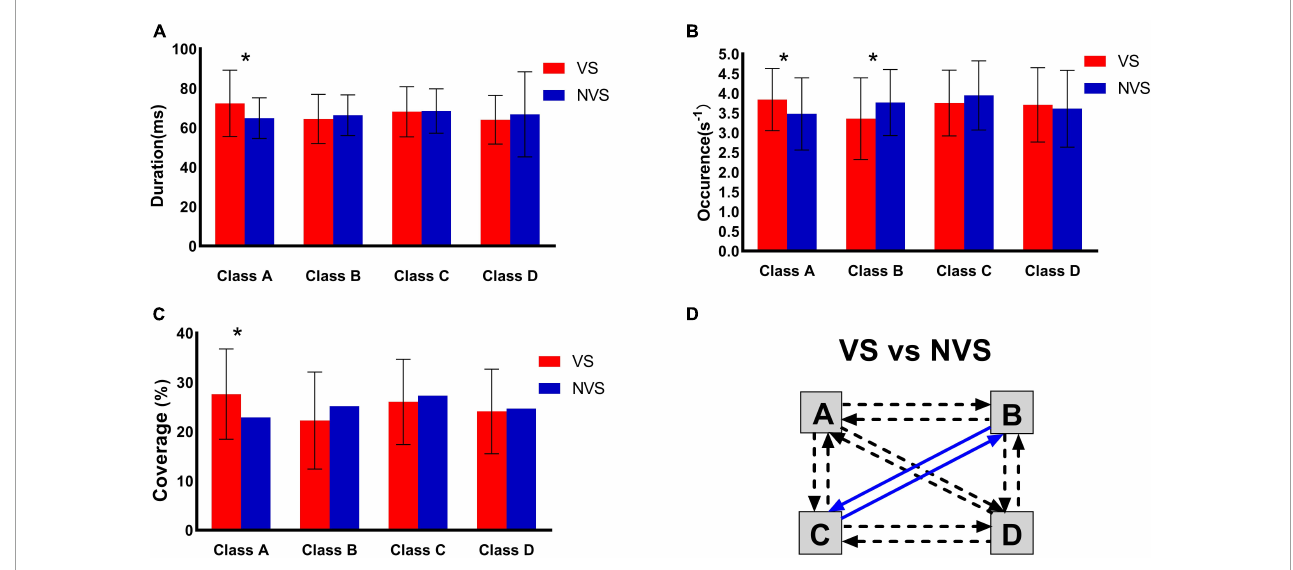
FIGURE2 Inter-group comparison of microstate parameters of the VS and NVS groups. (A) Duration, (B) occurrence, (C) coverage, and (D) transition probability. VS, violent patients with schizophrenia; NVS, non-violent patients with schizophrenia. *Indicates significant difference ( P < 0.05). Solid arrows indicate significant correlation. Blue arrows indicate a lower probability in violent patients with schizophrenia.